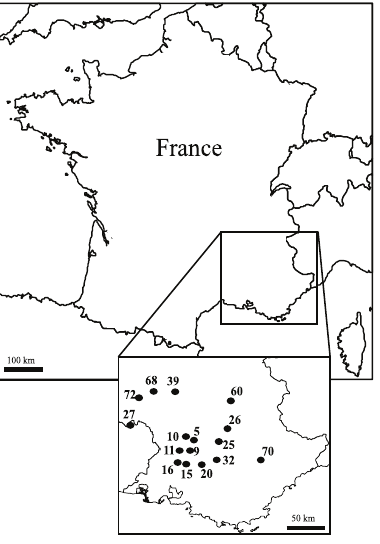
Figure 1. Sample locations of the 16 M.schimitscheki popula- tions used in this study. Informations associated with the site codes below are provided in Table 1.